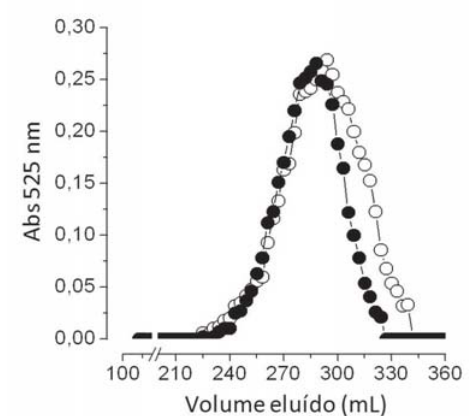
Fig. 4 – Análise comparativa do peso molecular das